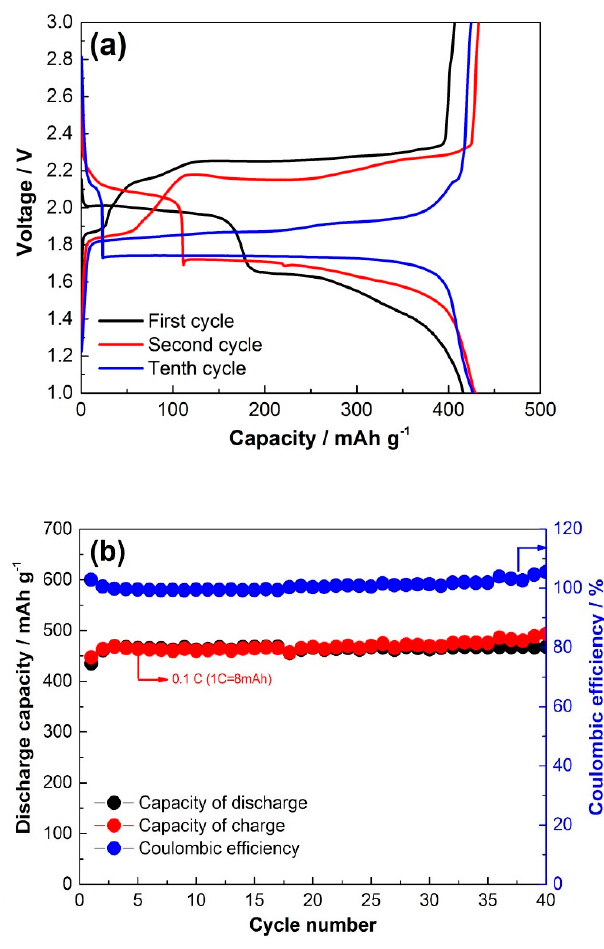
Figure 7. ( a ) Electrochemical charge–discharge and ( b ) cycling performance of CuS on Cu foam.